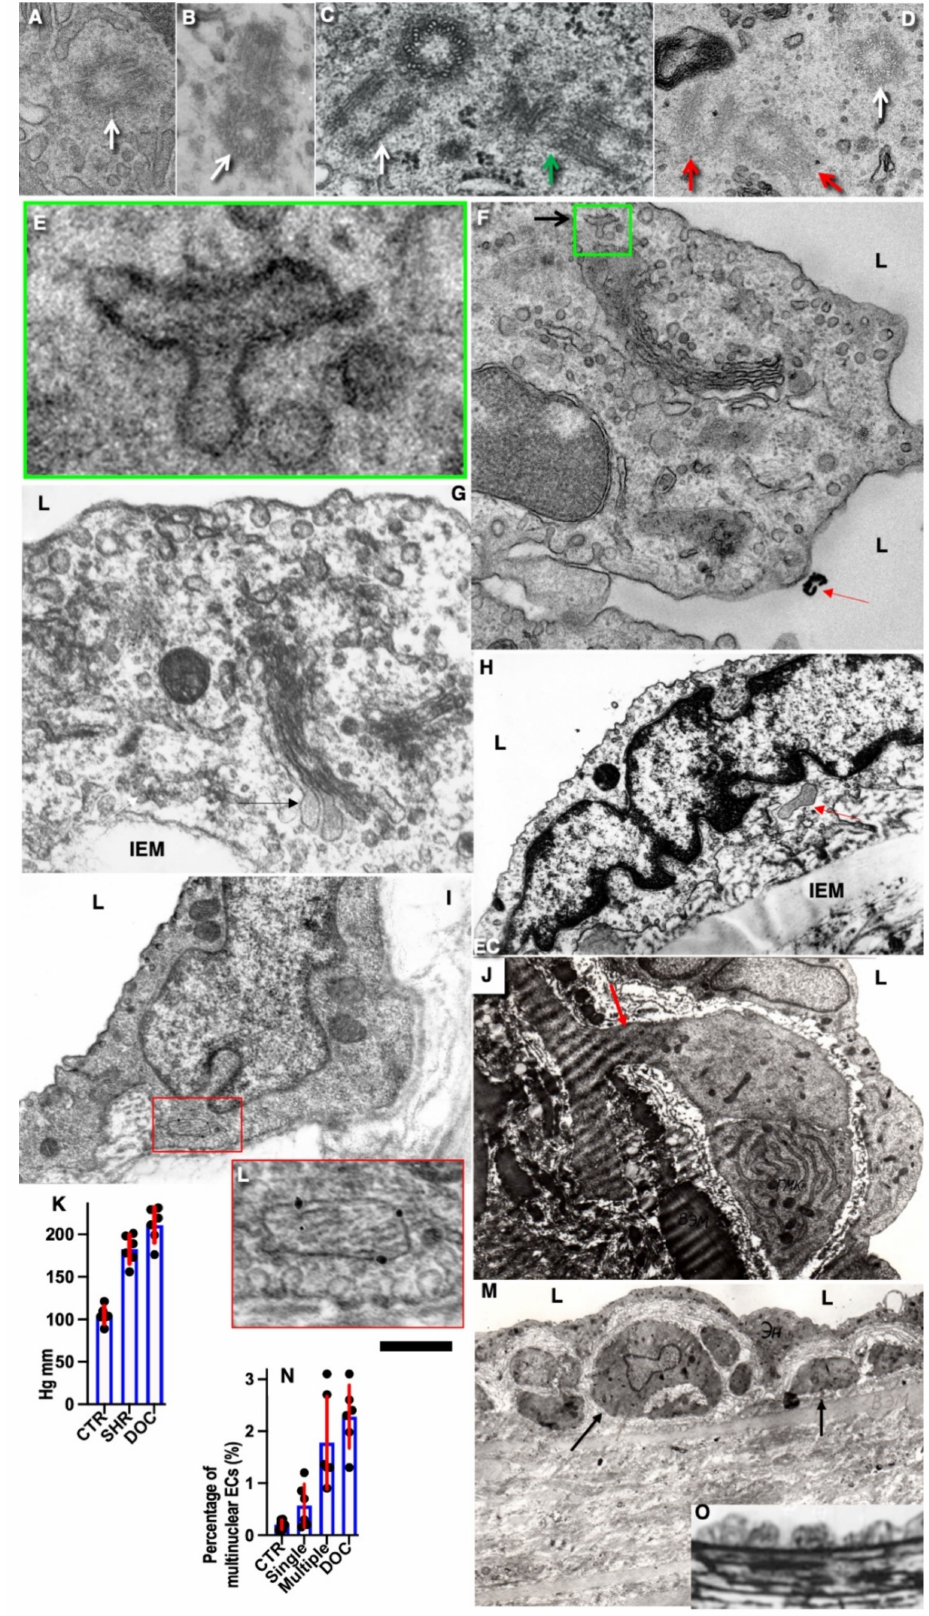
Figure 5. Structure of ECs during their re-endothelialization. ( A , B ) Centrioles (white arrows) in the G2-phase ECs. Only one pair of centrioles. ( C ) Centrioles in the S-phase EC. Two pairs of